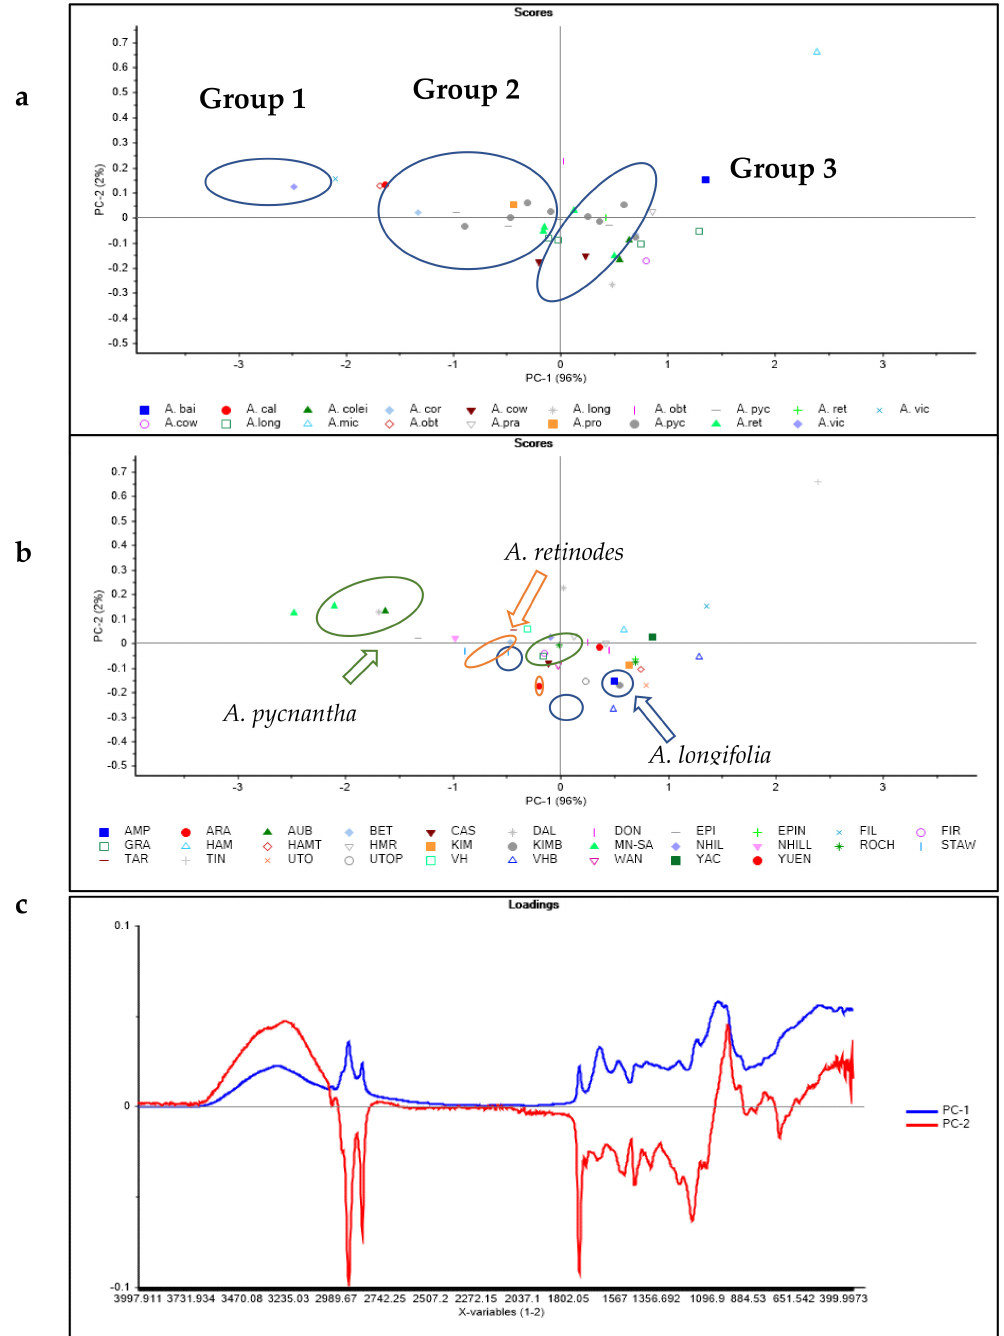
Figure 2. Principal component score plots of raw AS samples analysed by mid-infrared spectroscopy and labelled by ( a ) species, ( b ) region, and ( c ) their corresponding